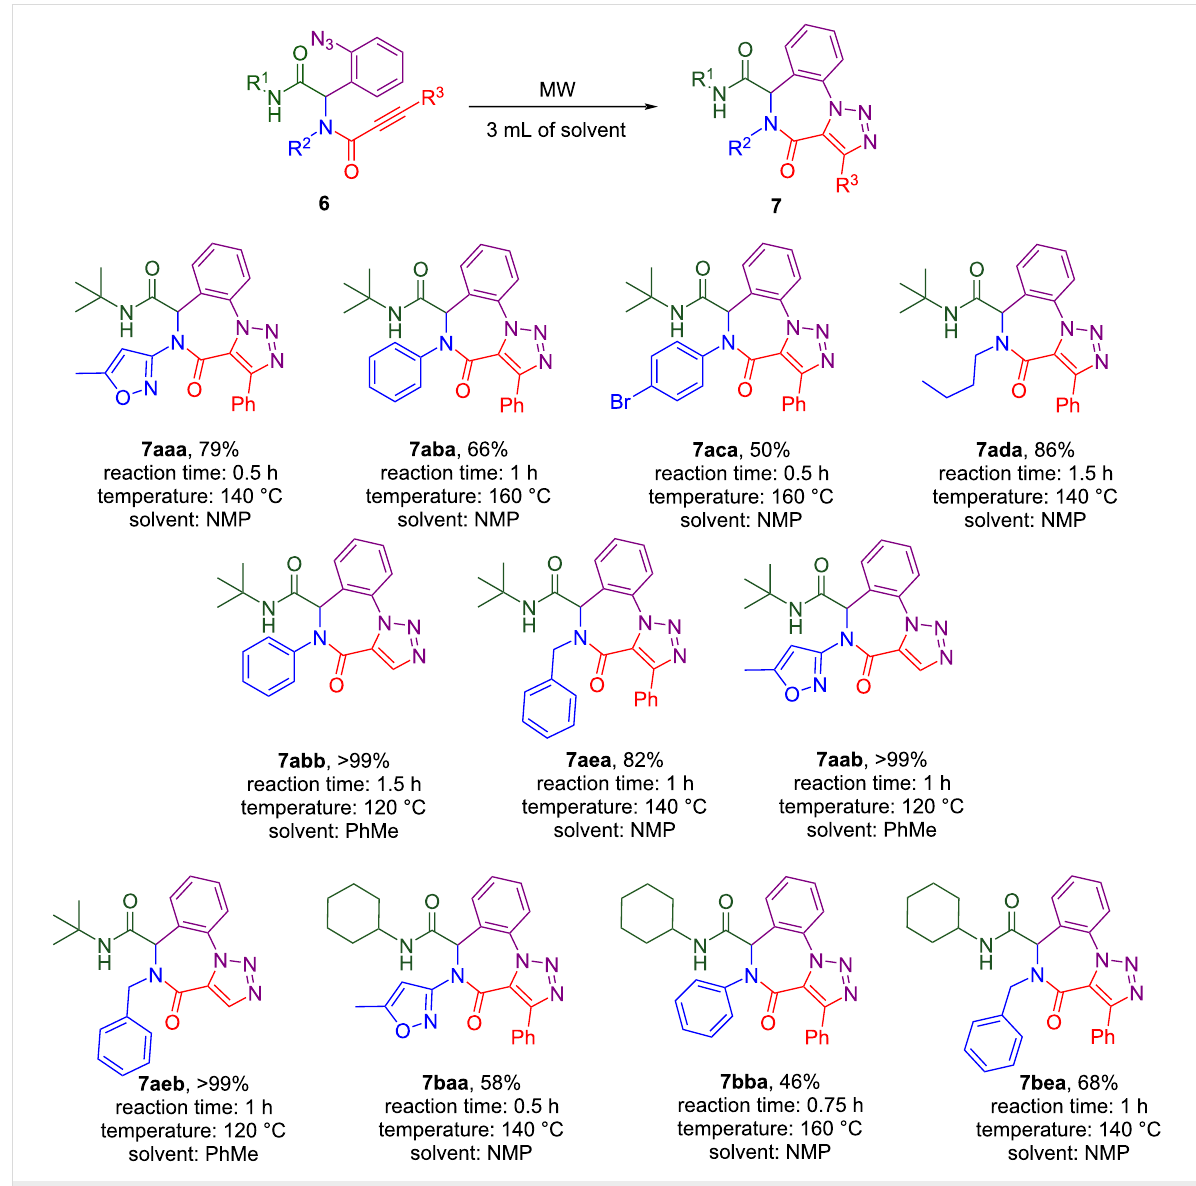
Scheme 5: The substrate scope of intermolecular